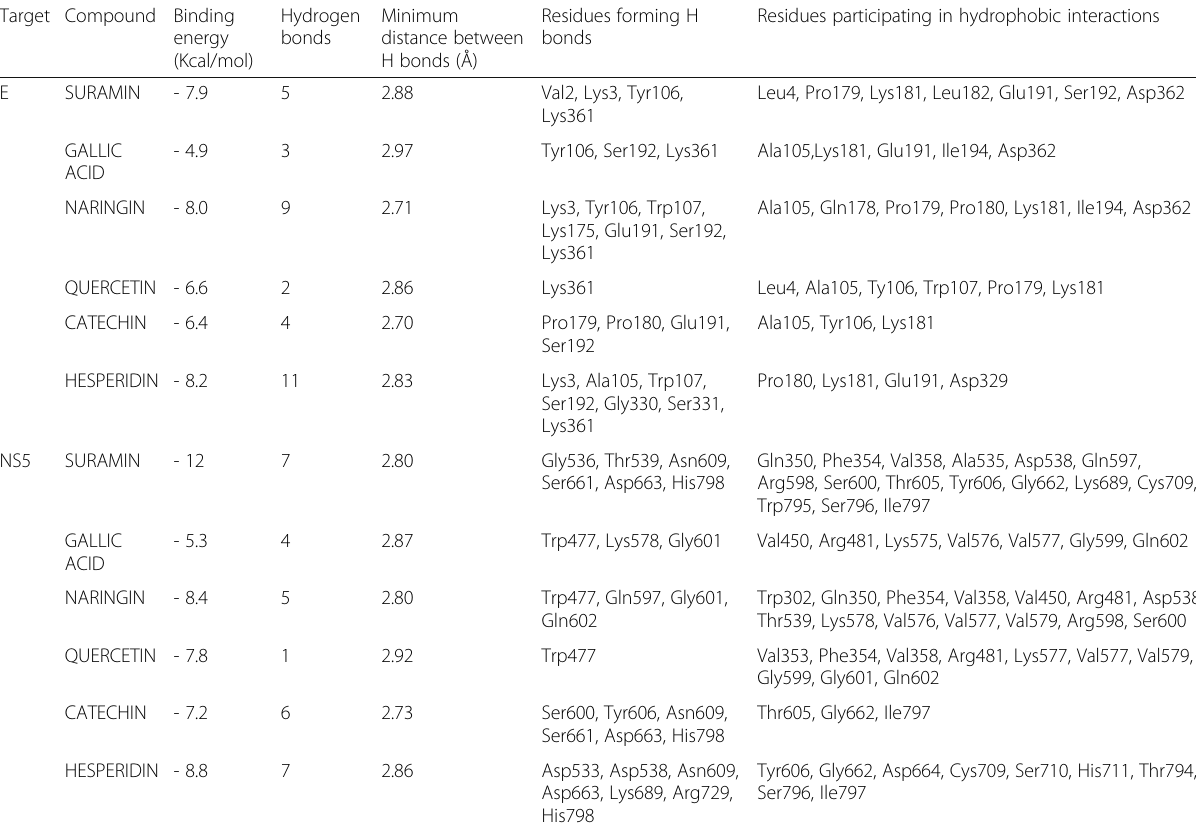
Residues participating in hydrophobic